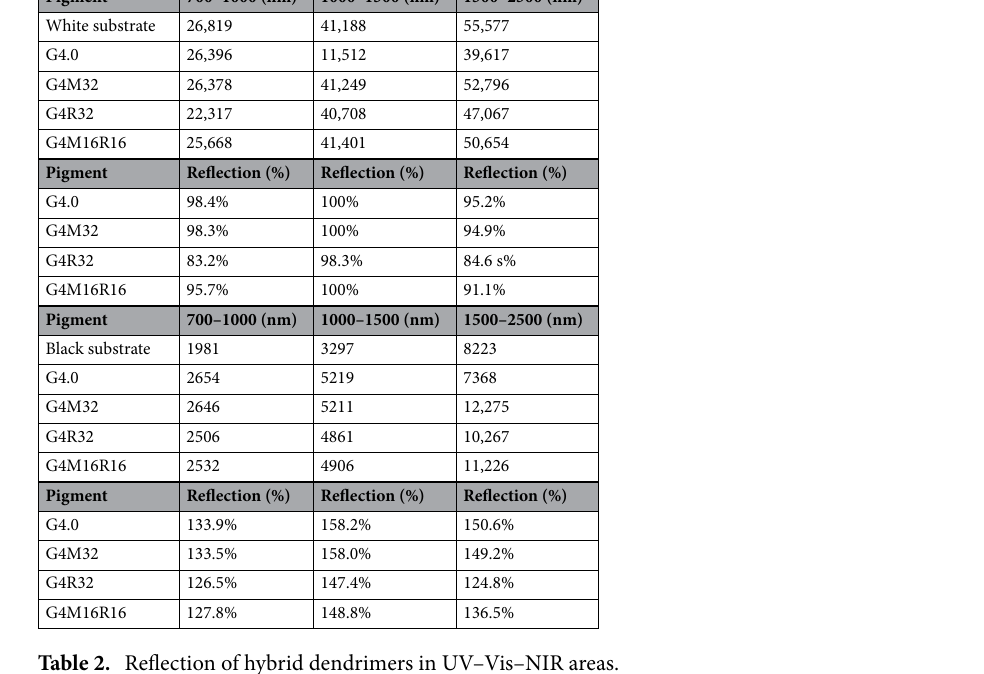
Table 2. Reflection of hybrid dendrimers in UV–Vis–NIR